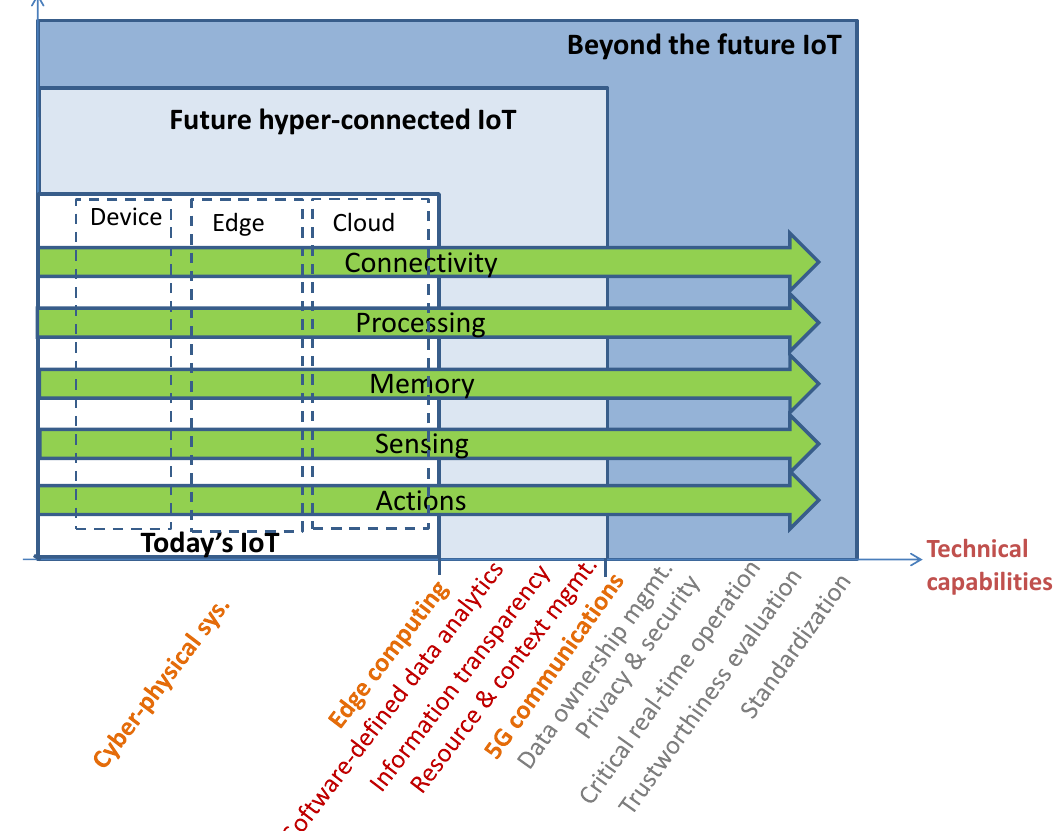
Figure 1. Key technical tipping points towards the future hyper-connected